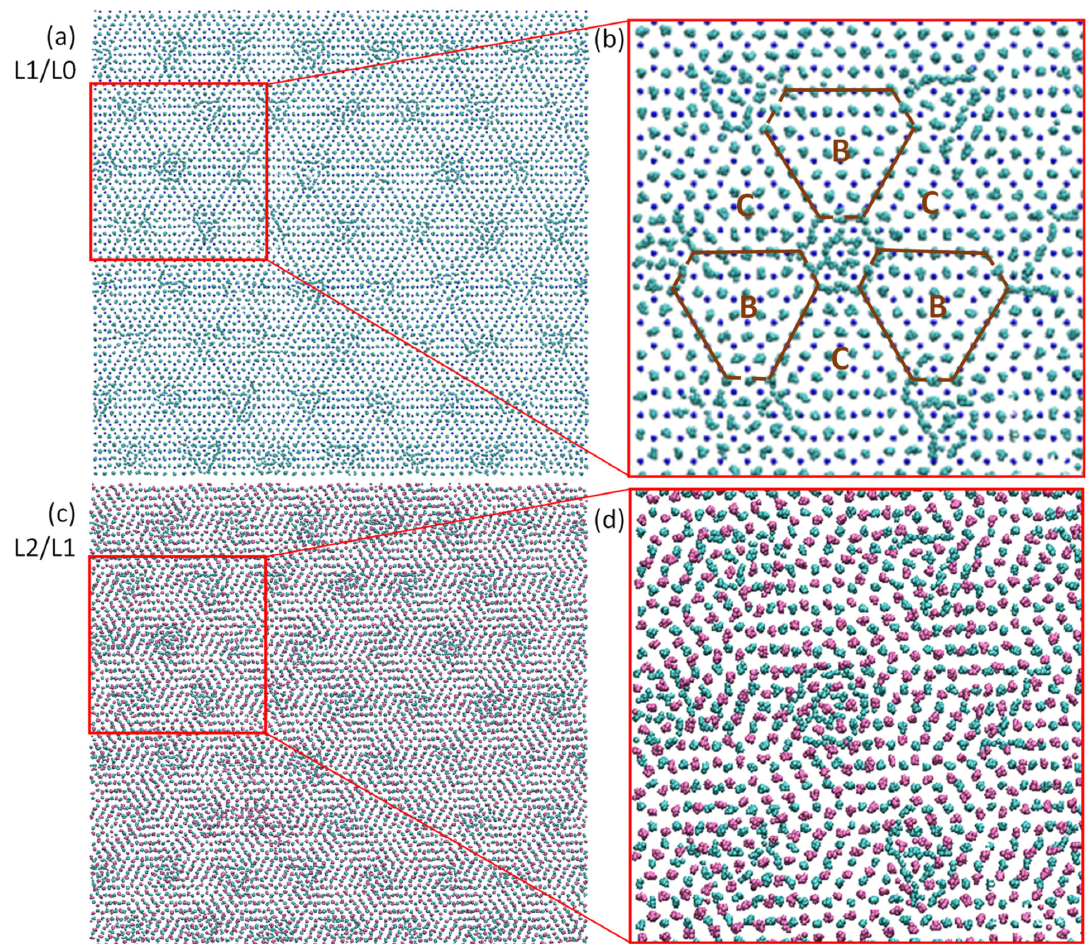
Figure 28. Structural templating. Time averaged atomic positions of atoms in ( a , b ) the L1 super- imposed on L0 and ( c , d ) the L2 superimposed on the L1 at the end of heterogeneous nucleation ( T n = 760 K, t 2 = 50 ps) in a system with − 8% misfit and 80,000 atoms. Normal solid atoms occupy either the “B” or “C” positions in L1, where “B” and “C” represents the atomic positions of ABCA . . . stacking sequence in the fcc lattice. The brown lines in the ( b ) represent the dislocation lines. It is noted that the atoms located at the nodes of dislocation network in L1 can hop between the “B” and “C” positions (denoted as “BC” atoms), with their trajectories forming a circular pattern centred on top of a substrate atom underneath. This suggests that the structural templating mechanism can take effect even in the node